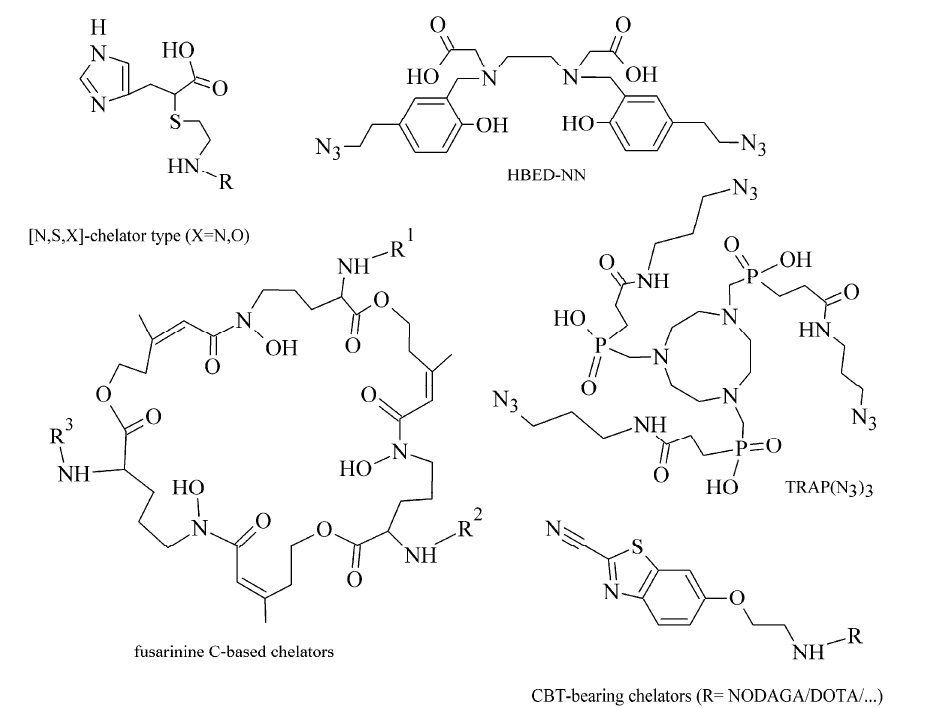
Figure 8. Examples of attractive clickable chelators for radiolabeling of biomolecules with metal radionuclides [106,108,111–113].